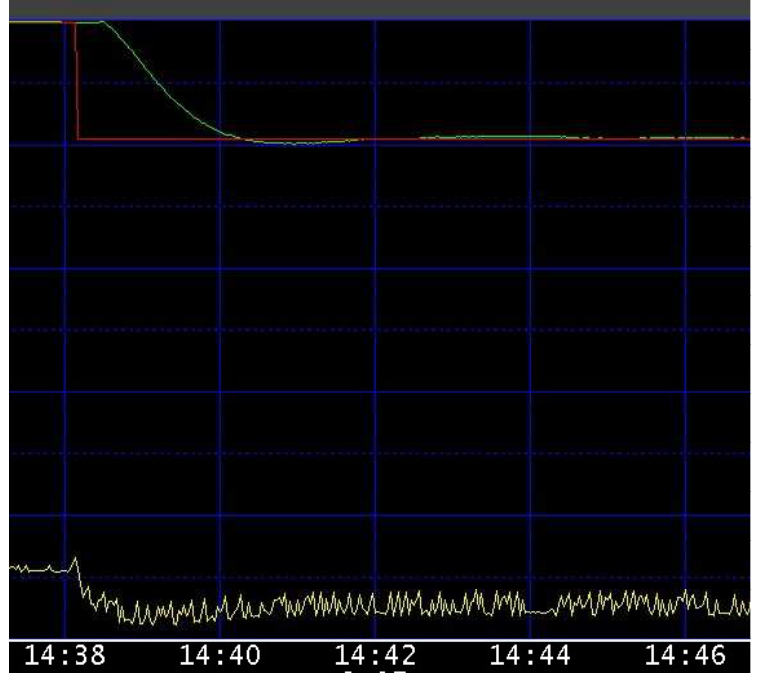
Figure 7. Set-point step response after the PID controller retuning in the flow control loop. Top: process variable. Bottom: control